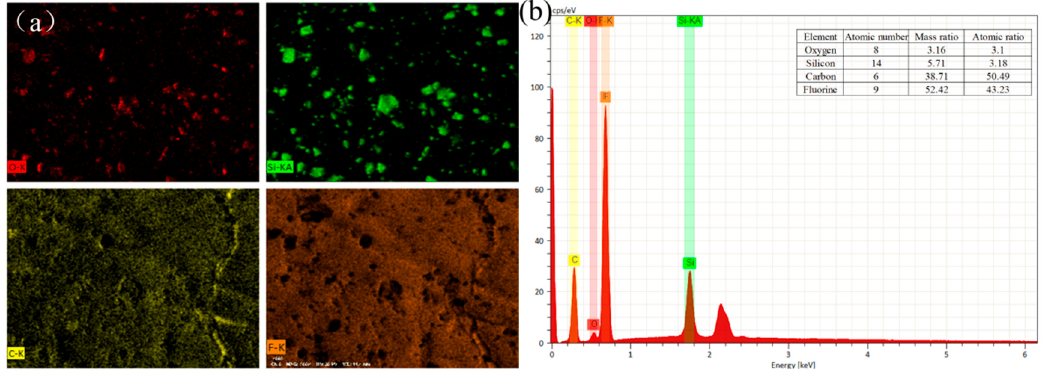
Figure 10. Energy dispersive spectrometer (EDS) analysis diagram of the PP / SiO 2 / PVDF composite with 4 wt % SiO 2 : ( a ) EDS mapping of O, C, Si and F and ( b ) elemental EDS analysis.